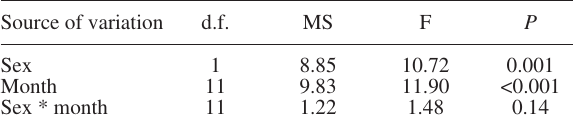
Table 3. – Analysis of variance of the hepatosomatic index (HSI) of Buenia affinis from the Kvarner area versus sex and month.